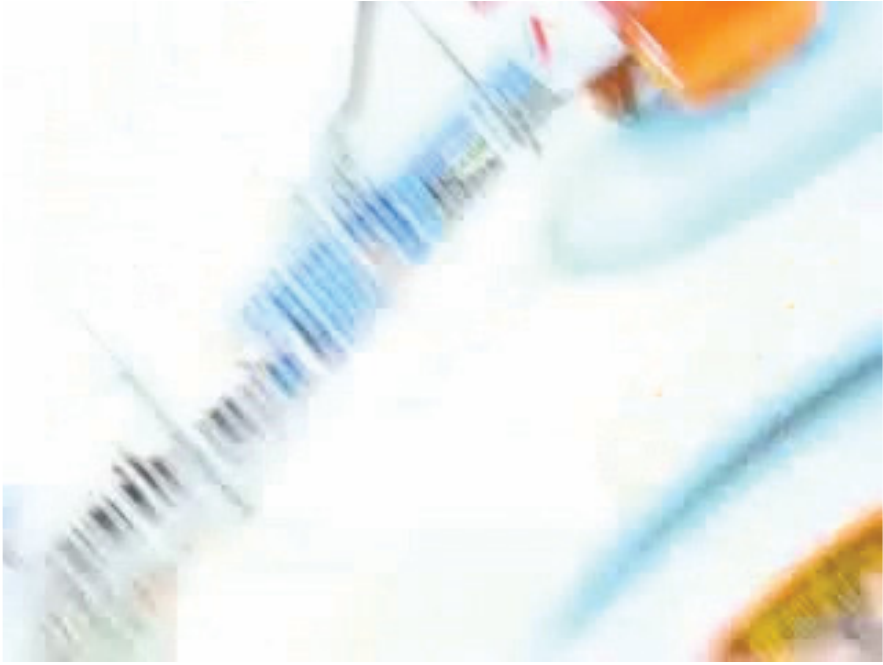
Figure 4. Confession Diptych (2007). Digital film still: A manic carnival ride paired with tinny audio of devout singing audio.